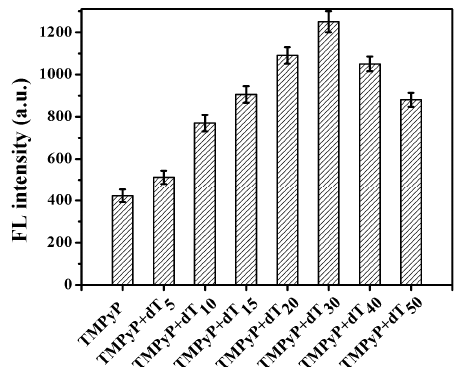
Figure 3. Dependence of fluorescence intensity on the sequence length of poly T. The fluorescence was excited at 422 nm and measured at 660 nm. The absolute errors deduced from three replicate measurements are shown as the error bars.